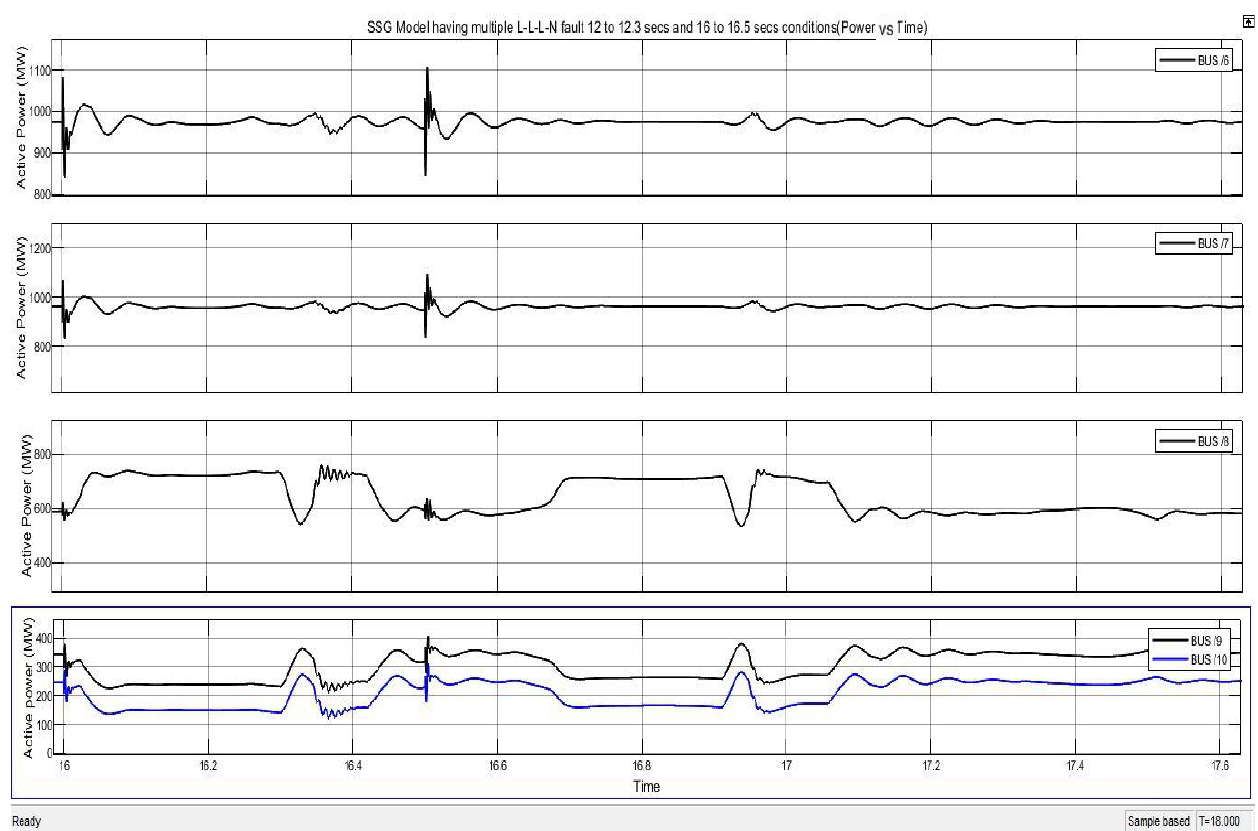
Figure 34. Multiple line-to-line (L-L-L-N) faults are inserted in the system from 16 to 16.5 s (Bus 6 to Bus 10). Bus